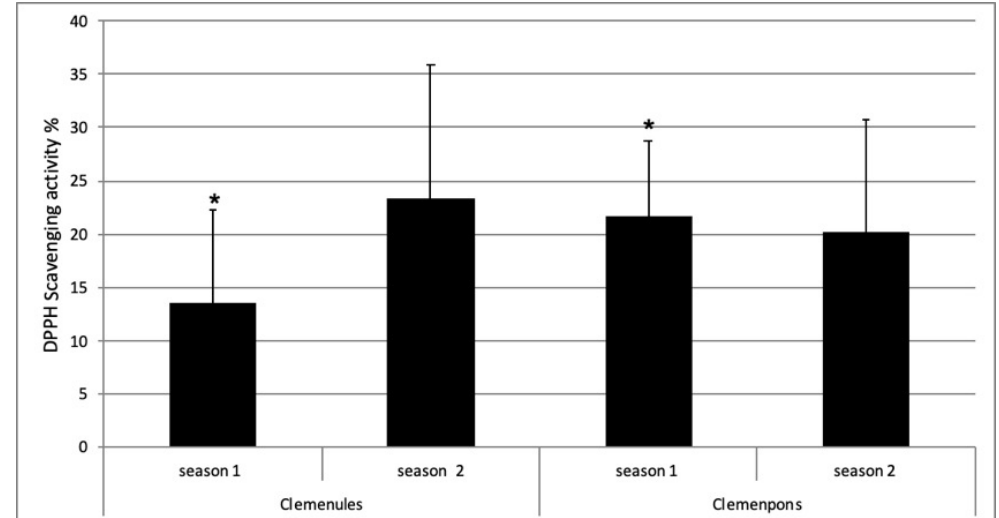
Figure 4 . Antioxidant activity of Clemenules (NL) and Clemenpons (PO) EO during two seasons. No statistically significant differences were observed between the two varieties including all data of both seasons and including only data of s2 ( p > 0.05, according to Student’s t -test). * There were statistically significant differences between NL and PO for s1 ( p < 0.05, according to Student’s t -test).